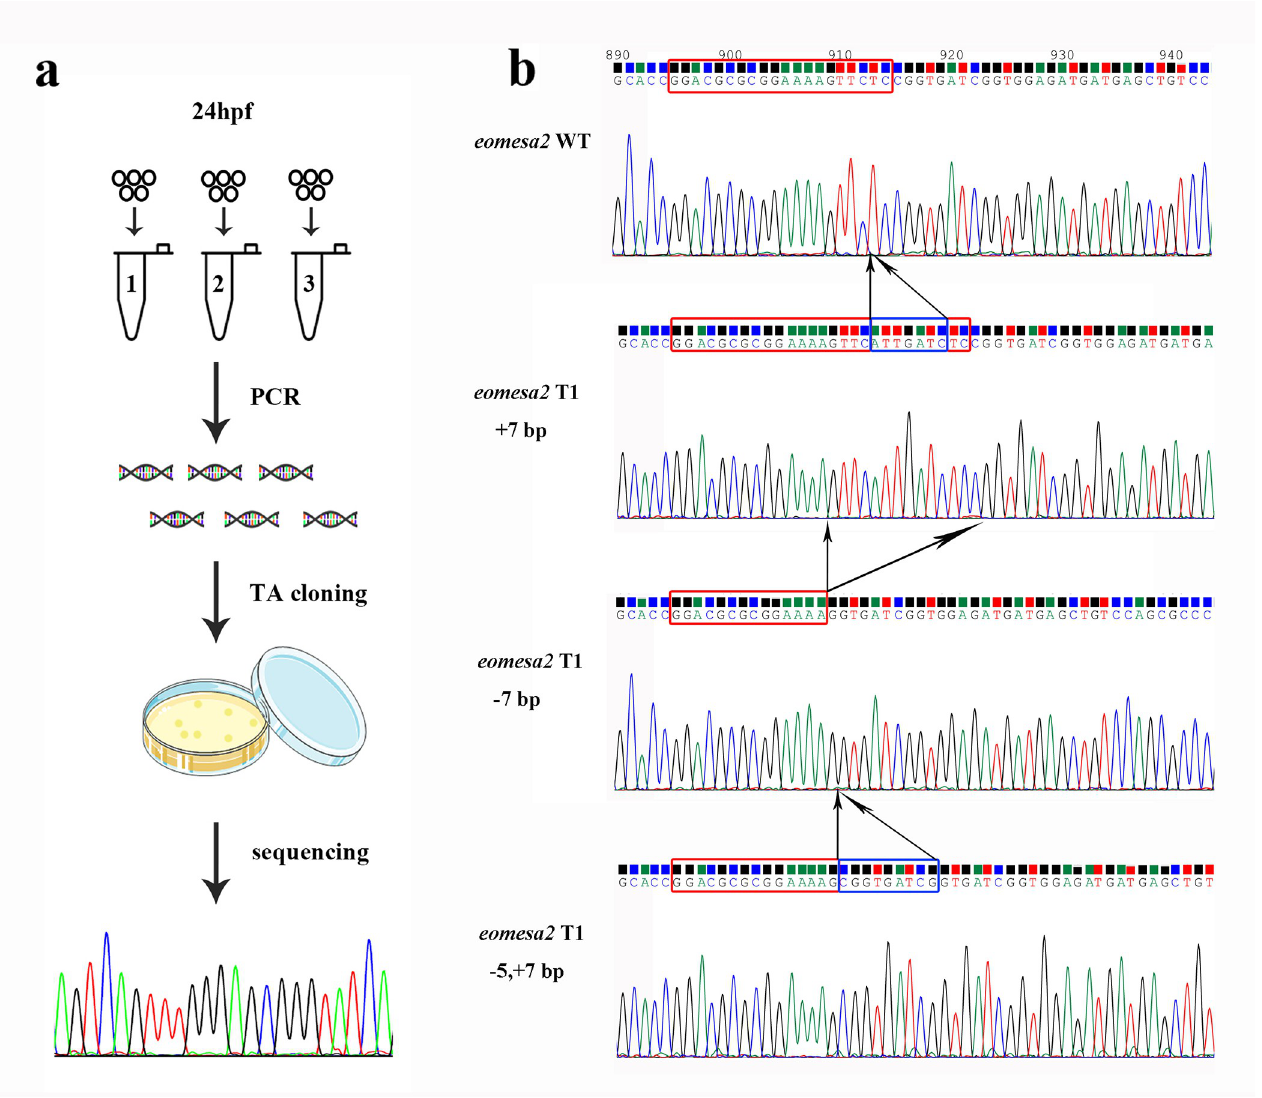
Fig 2. The efficiency of knock out at the eomesa1 and eomesa2 loci was evaluated by Sanger sequencing method at 24 hours post fertilization. (a) The procedure of gene editing efficiency measurement on 24 hpf embryo. (b) The sequencing chromatographs of TA cloning results show the representatives of three types of mutations including insertion (+7 bp), deletion (-7 bp) and both (-5,+7 bp) around T1 of eomesa1 locus. The red rectangles indicate the target bases, and the blue rectangles indicate the inserted